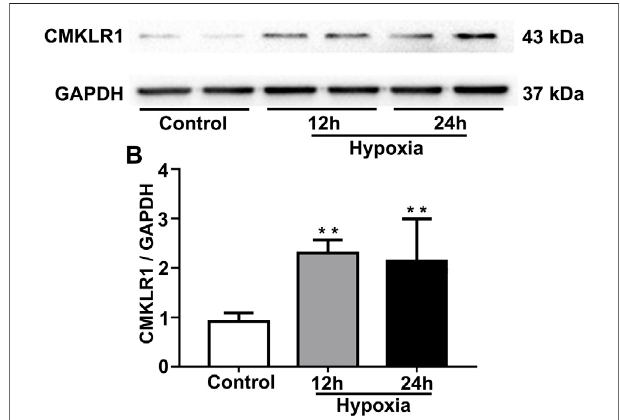
FIGURE 3 | CMKLR1 expression is upregulated in PASMCs under hypoxic conditions. To mimic PH in vitro , PASMCs were exposed to hypoxia (2%) for two different durations (12 and 24 h). (A,B) Western blot analysis of CMKLR1 expression in the groups. ** p ＜ 0.01 vs. the control